Question: Provide a one-line summary of what is displayed.
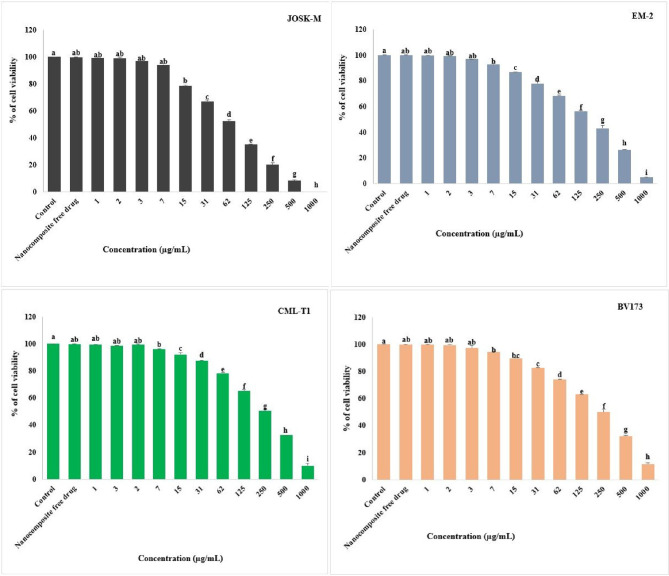
Answer: Cytotoxic effects of CNH beads on CML cell lines JOSK-M, EM-2, CML-T1, and BV173. Cytotoxicity evaluation in CML cell lines (JOSK-M, EM-2, CML-T1, and BV173) demonstrated that the investigated CNH-LDH@Fe₂O₃ formulations exhibited concentration-dependent cytotoxicity against leukemic cells.